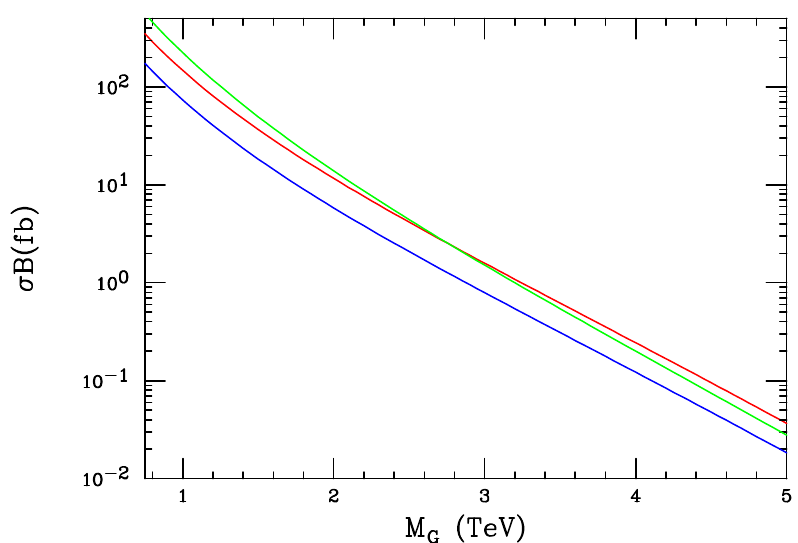
Figure 1 . Production cross sections for the lightest KK graviton production at the 13 TeV LHC for several of our benchmark models. For the cases where the SM is constrained to the TeV brane the red(blue) curve is weighted by the branching fraction into the (cid:13)(cid:13) ( ‘ + ‘ (cid:0) ) (cid:12)nal states with production occurring through both gg and q (cid:22) q annihilation. In the GW benchmark case (green), the result includes the branching fraction into diphotons and only has contributions from the gg production channel since there is essentially no coupling to light quarks (or leptons) in this case. For the MOR benchmark, the result is similar to that for GW apart from an overall normalization factor of ’